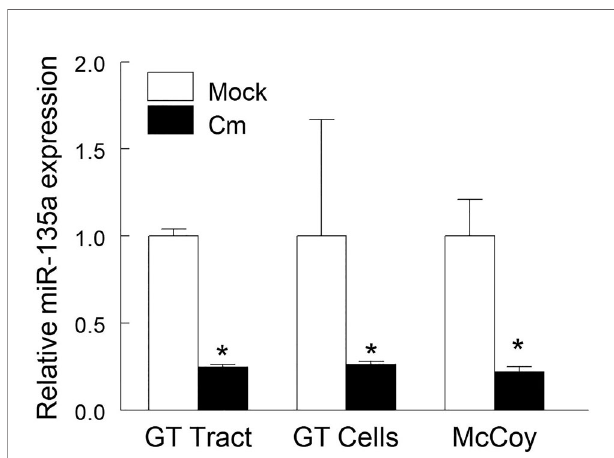
FIGURE 1 | Chlamydia muridarum infection down-regulates miR-135a. C57BL/6 mice (n = 3) were intravaginally challenged with Cm (5 × 10 4 IFUs in